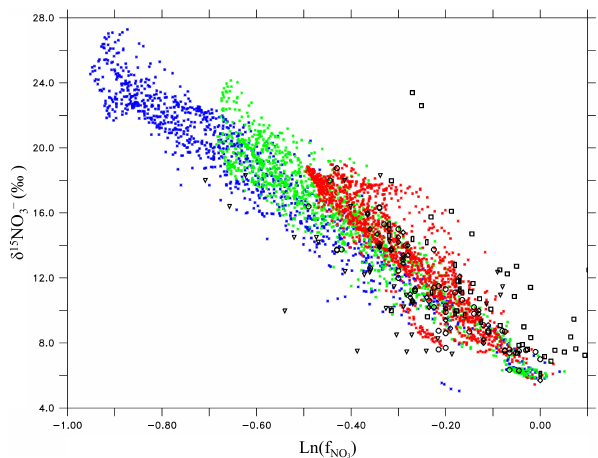
Fig. 5. Annual mean δ 15 NO − versus expected nitrate ( f NO ) shows 3 3 the increase of δ 15 NO − as NO − is consumed in suboxic zones 3 3 (O 2 < 10µM) from the isotope effect of water column N-loss in limWCD = 20 (blue), limWCD = 26 (green), limWCD = 32 (red) and observations (black) from Cline and Kaplan (1975) ( [] ), Alta- bet et al. (1995) ( 1 ), Brandes et al. (1998) ( ♦ ) , Voss et al. (2001) ( ◦ ), and Somes et al. (2010b) ( (cid:3) ). Note ε BD = 0‰ for the model experiments shown here. Expected nitrate is determined to be at the elemental ratio 15 · PO 3 − in the model based on experiments where 4 WCD was switched off (not shown), which is in agreement with the expected nitrate calculation from Voss et al. (2001) based on nitrate- density isopycnals. Observations near the seafloor are excluded to avoid any impact from benthic